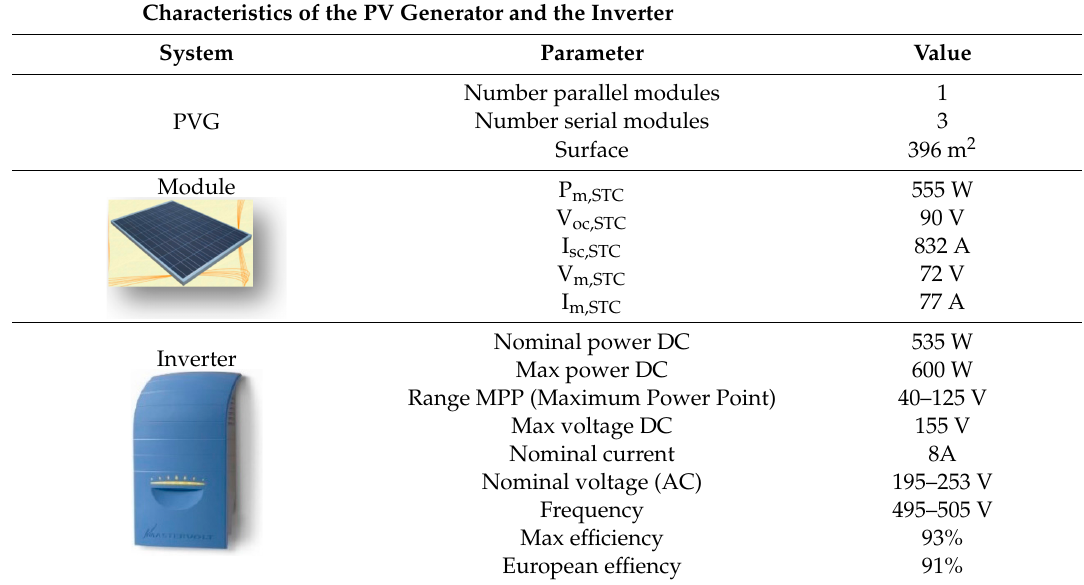
Table 1. The main characteristics of the photovoltaic generator (PVG).